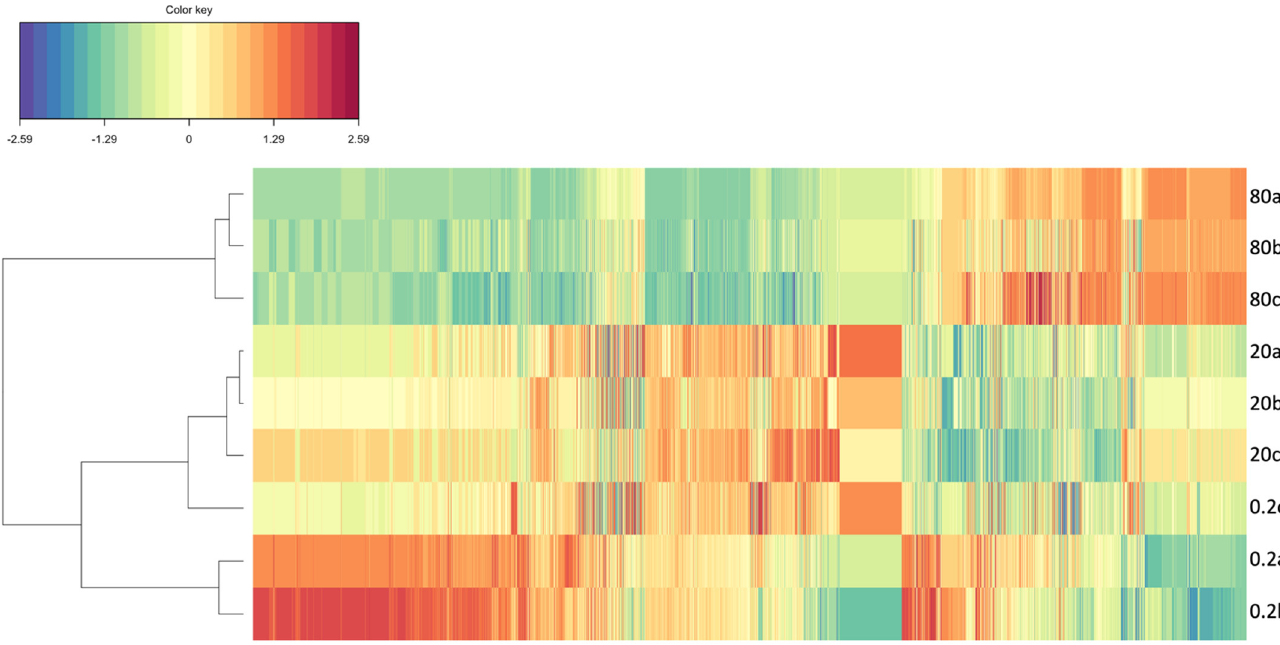
Figure 7. Fold-change Clustered Image Map (CIM) and respective Euclidean Dissimilarity dendro- gram based on the metabolite fold-changes of the cells exposed to 0.2, 20 and 80 µ g/L fluoxetine and respective replicates (a, b, and c). Each tile represents a